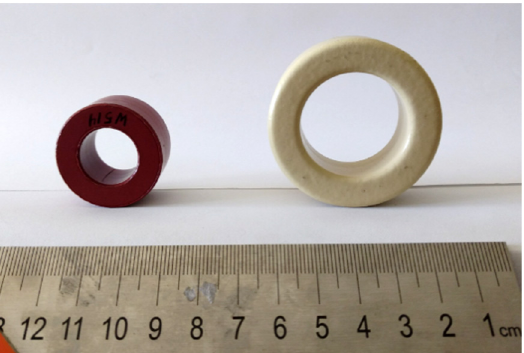
Figure 8. Cores for the construction of both MFTs: ( left ): Nanocrystalline, ( right ): Ferrite.